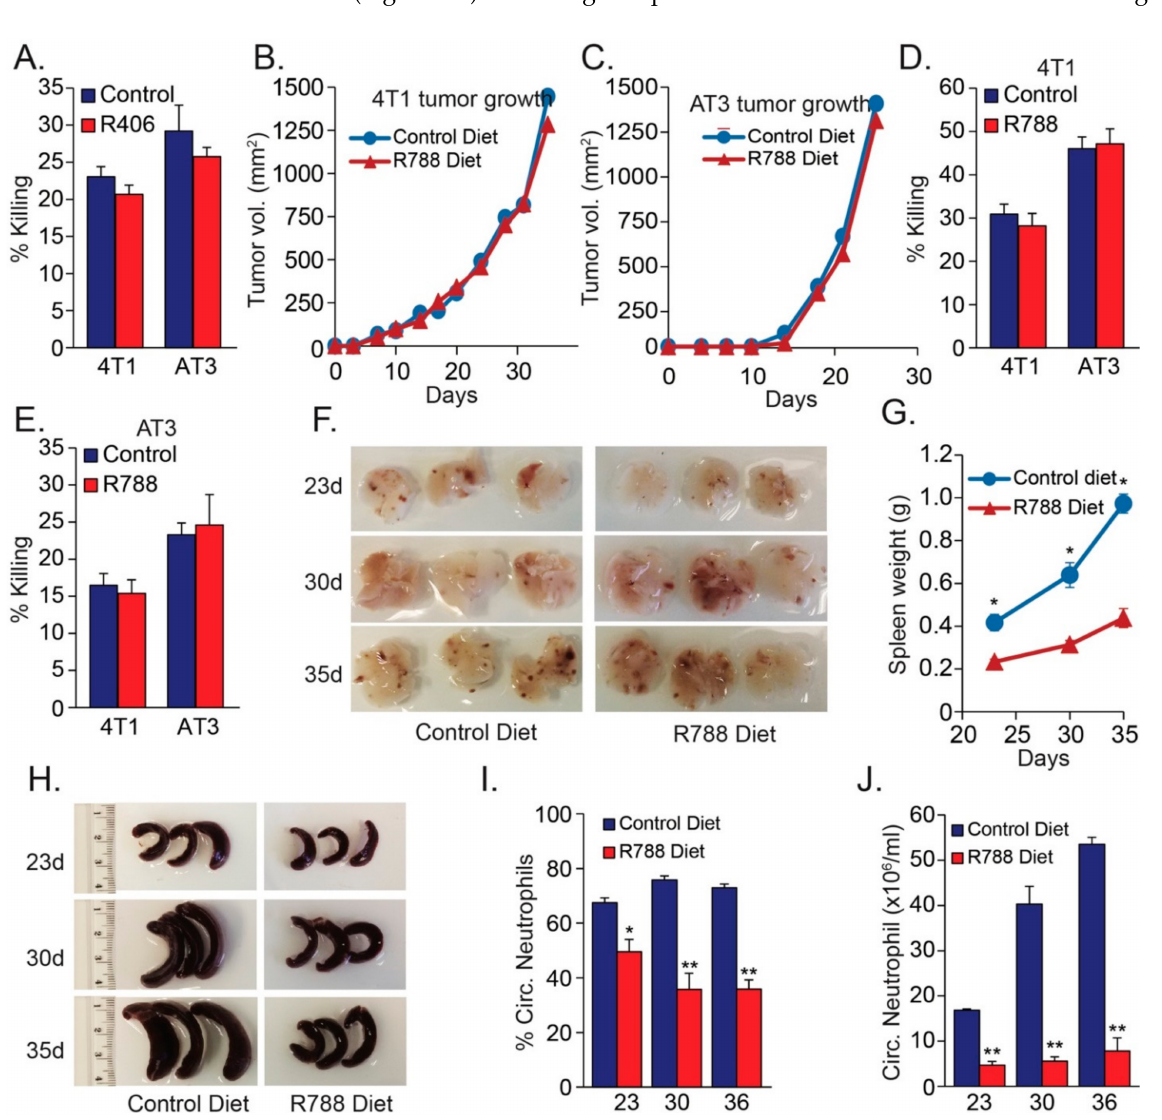
Figure 3. ( A ) Cytotoxicity of neutrophils pretreated in vitro 30 min with 10 µ M SYK inhibitor R406 towards 4T1 and AT3 cells. ( A – C ) Local tumor growth of 4T1 ( B ) or AT3 ( C ) in mice that have been given control or R788-containing diet. ( D , E ). Cytotoxicity of neutrophils isolated from 4T1 ( D ) or AT3 ( E )-tumor bearing mice that have been given control or R788-containing diet. ( F ) Lungs from 4T1-bearing mice that have been given control or R788-containing diet for 23, 30 and 35 days. ( G , H ) Spleen from 4T1-bearing mice that have been given control or R788-containing diet for 23, 30 and 35 days. ( I ) Percentage neutrophils in blood samples from 4T1-bearing mice that have been given control or R788-containing diet for 23, 30 and 35 days. ( J ) The neutrophil count in 1 mL blood samples from 4T1-bearing mice that have been given control or R788-containing diet for 23, 30 and 35 days. * p < 0.05; ** p <